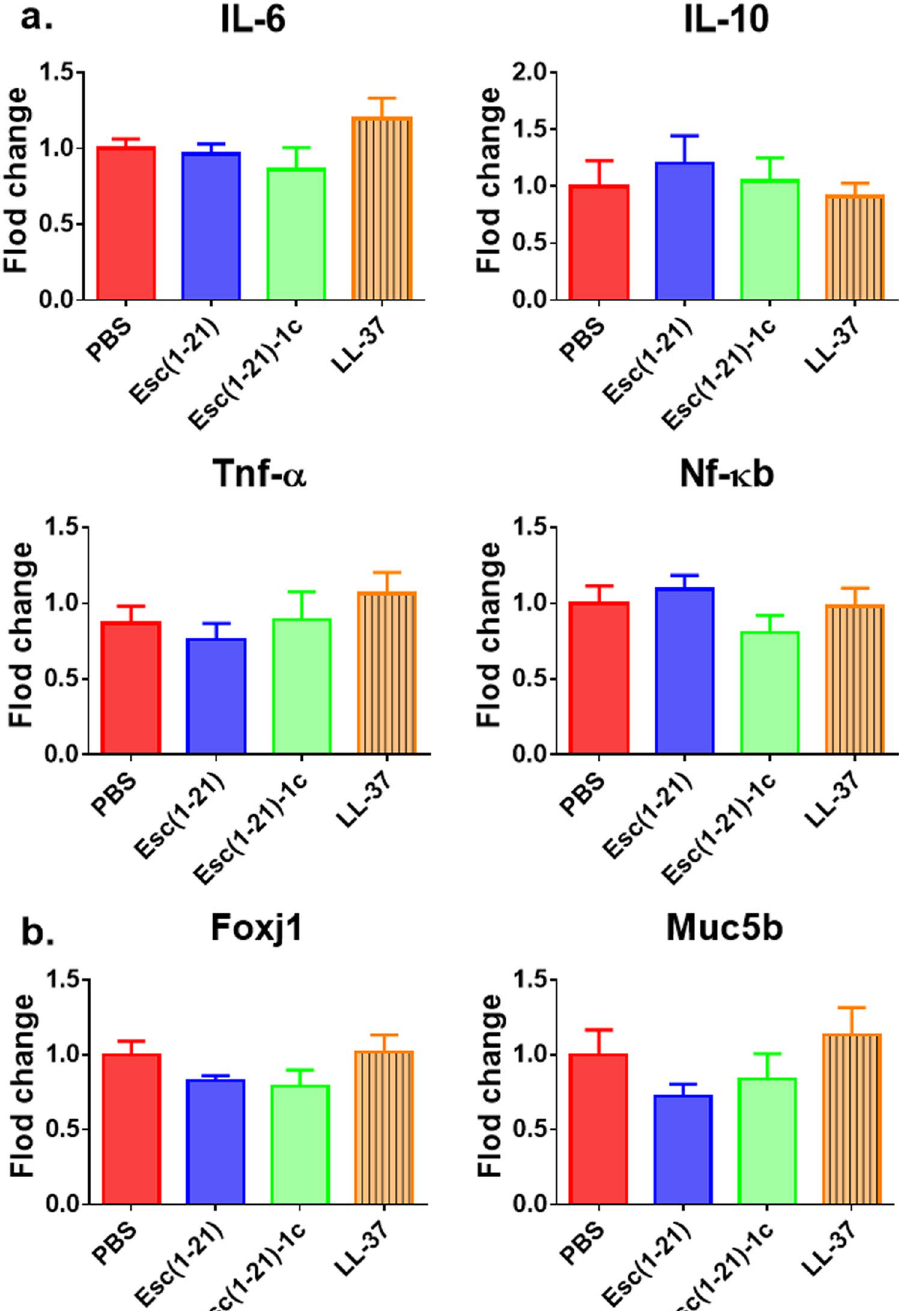
Figure 3. Comparison among Esc(1–21), Esc(1–21)-1c and LL-37 on the in vivo gene expression in the lungs of mice. Effects of peptides on the expression of different inflammatory genes (panel a) or mucociliary-associated genes (panel b) in the lungs of mice after 24 hours from peptide administration at 0.1 mg/kg. AMPs treatments at 0.1 mg/kg do not noticeably affect the expression of inflammation and mucociliary clearance-related genes. Results are mean ± SEM from two independent experiments; n = 4–6 mice for each group in each